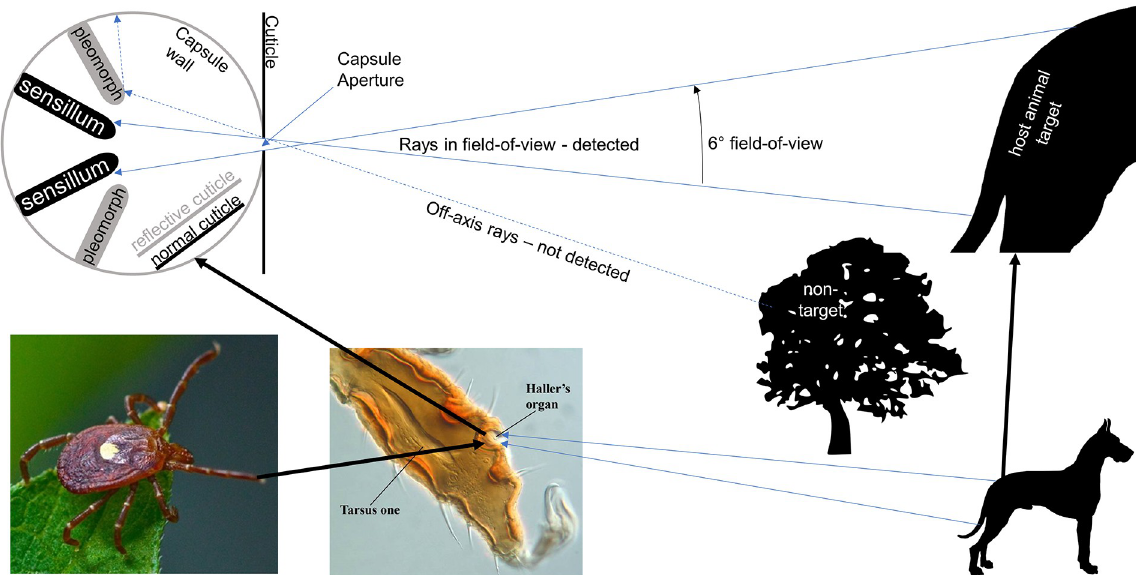
Fig 8. Proposed function of the Haller’s organ capsule as a radiant heat sensor. When the aperture of the the Haller’s organ capsule near the tip of the foretarsus is directed at a warm target, infrared radiation within a narrow field of view passes through the aperture and warms the sensilla located deep within the capsule, whereas off-axis rays from non-target areas will be blocked by reflective pleomorphs and not influence the sensilla. The sensilla will be warmed to the average temperature within the field of view. The walls of the capsule and the pleomorphs are reflective and so will not radiate to the sensilla but instead will insulate them. Reflective cuticle is grey and normal cuticle is black. Image of female lone star tick, Amblyomma americanum , on leaf from Ticksafety.com, with permission. Differential interference contrast micrograph of the foretarsus of a larval Haemophysalis tick, from [26], with permission from W. Knee and H.